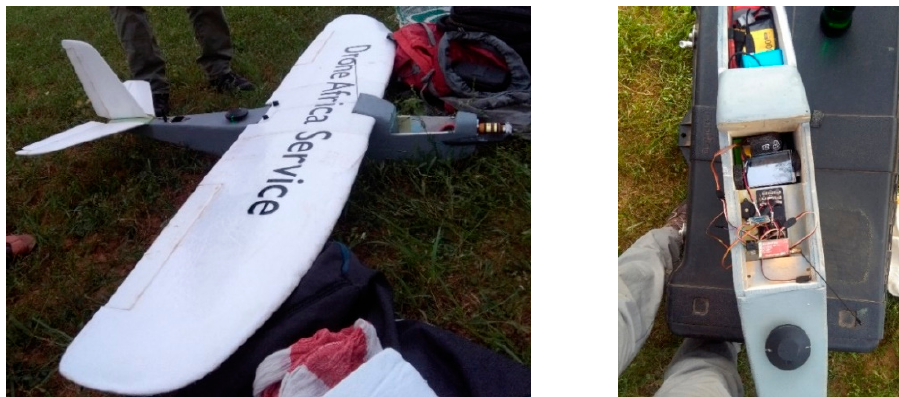
Figure 3. Left : UAS system built by Drone Africa Service. Right : Detail of the UAS body. It is visible that the Raspberry Pi sensor is mounted on the UAS system; 3.5-inch screen and the GPS receiver.